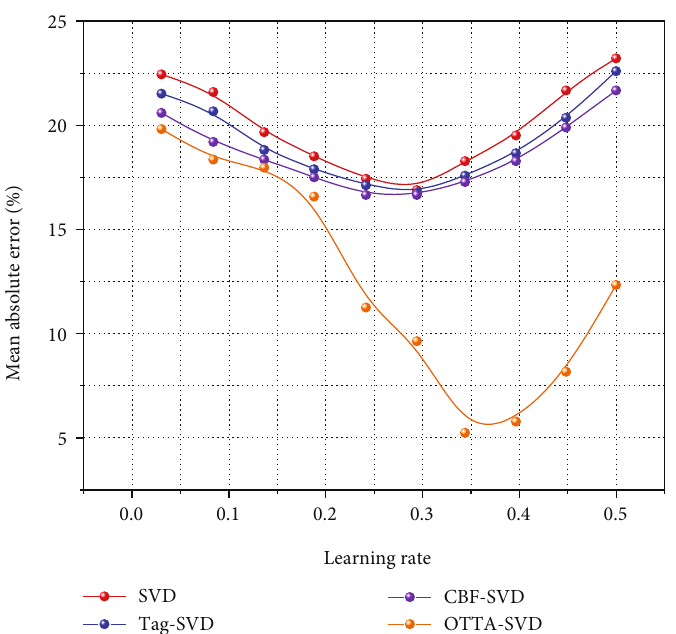
Figure 9: E ff ect of learning rate α on MAE.